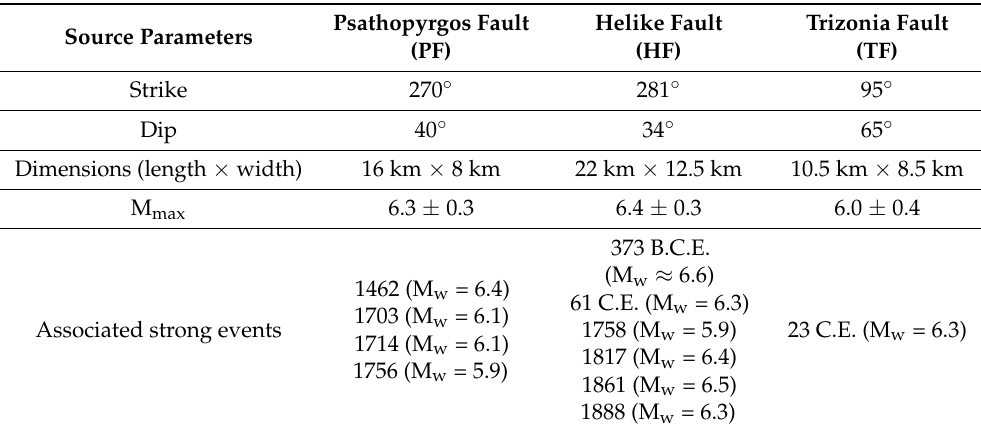
Table 2. Stochastic modeling source parameters for the three selected seismic scenarios. Fault orientation and dimensions were adopted from various sources [6,38,90]. Associated past strong events were adopted from Boiselet